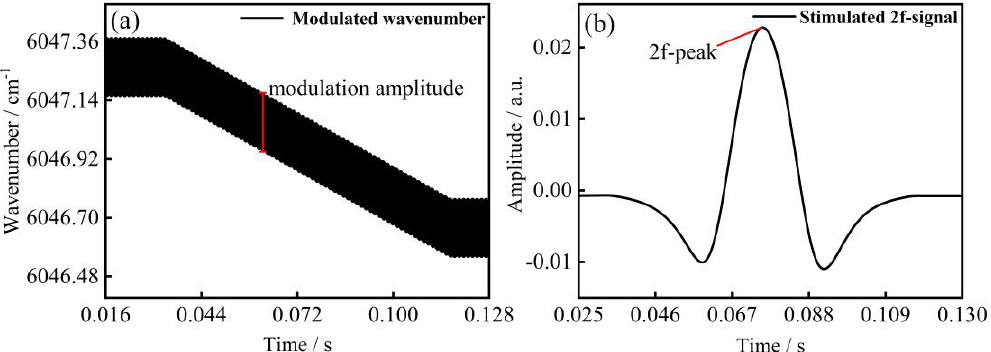
Figure 2. Numerical simulation results. ( a ) Modulation amplitude; ( b ) 2f-signal.